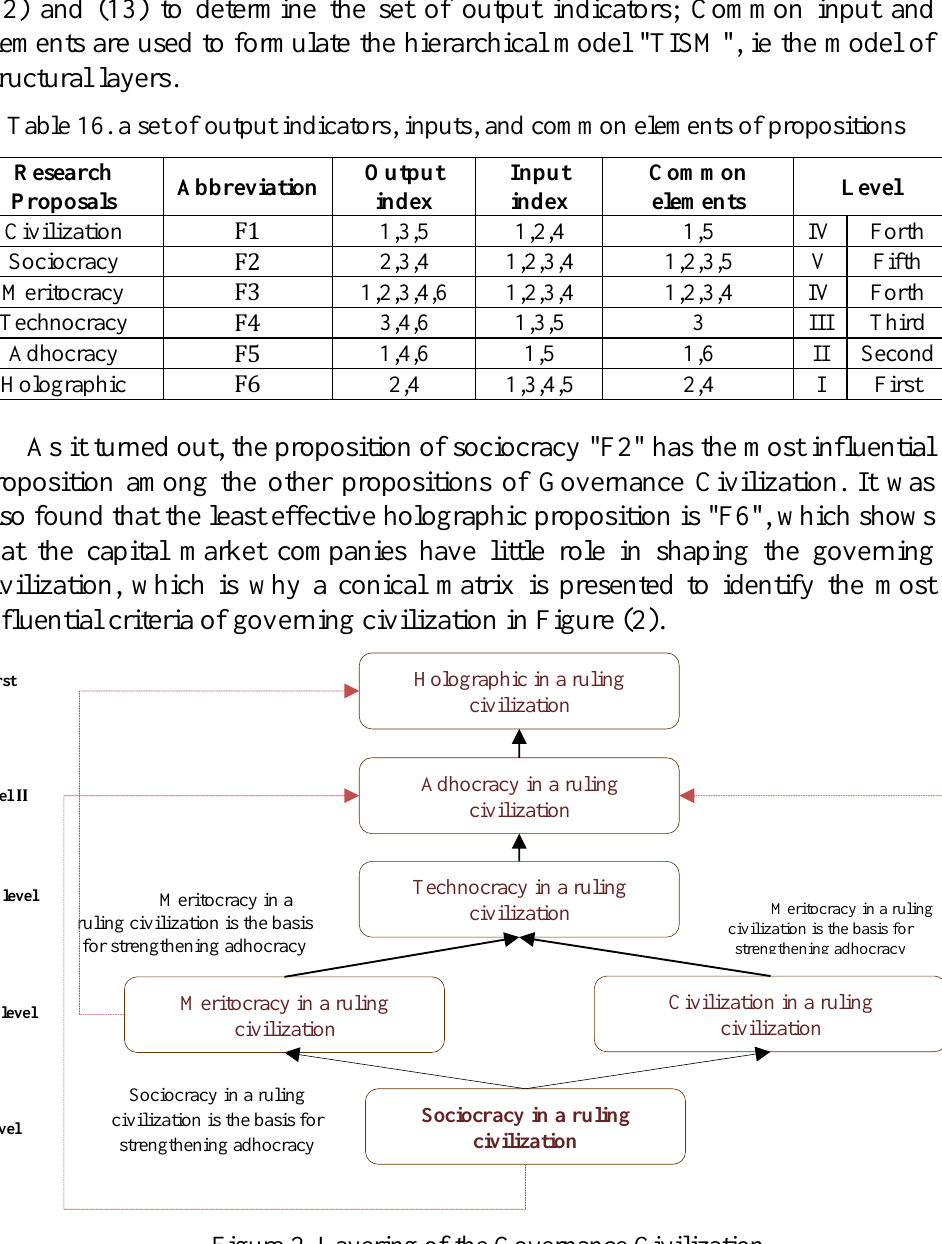
Figure 2. Layering of the Governance